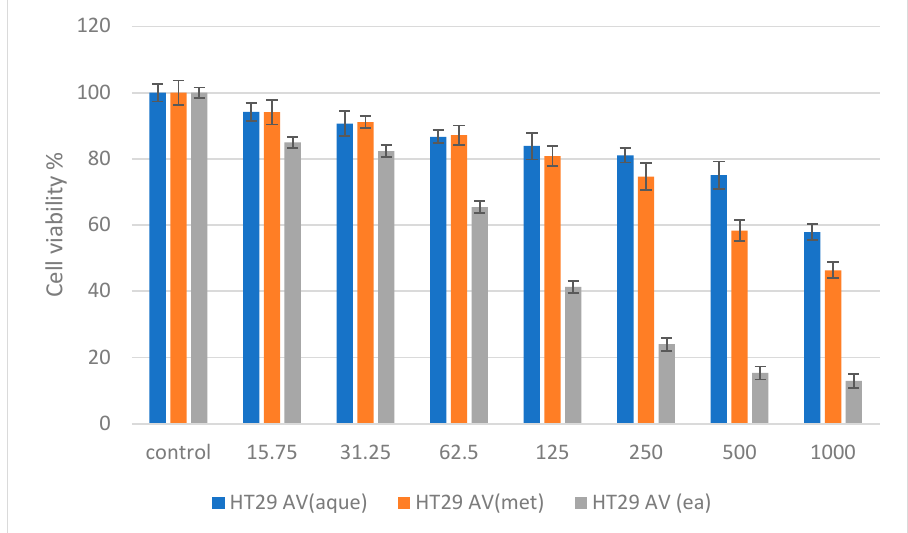
Figure 4. Cytotoxicity assay of Artemisia verlotiorum in aqueous, methanolic, and ethyl acetate extracts against human colorectal carcinoma HT29 cells at 48 h.